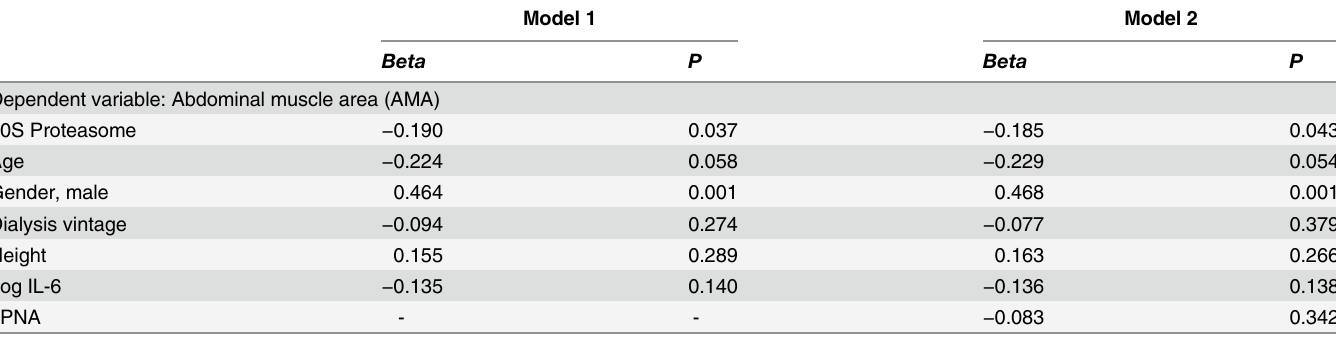
Table 3. Multiple Regression Analysis using Abdominal Muscle Area (AMA) as the Dependent Variable and 20S Proteasome, Age, Sex, Dialysis Vintage, Height, Log IL-6 and nPNA as Independent